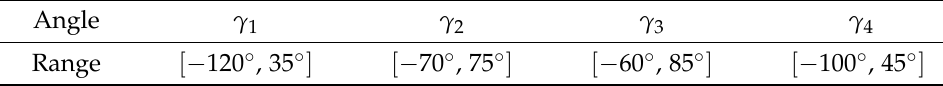
Table 10. Starting angular position for the numerical examples—Second Case.